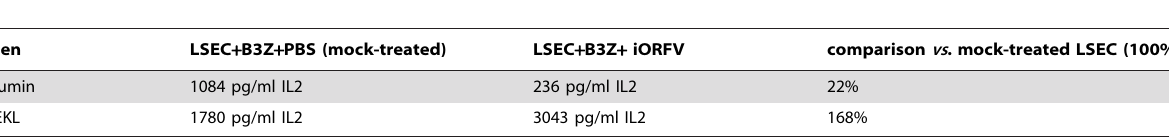
Table 2. iORFV (D1701) reduces antigen cross-presentation by liver sinus endothelial cells (LSEC) but enhances activation of T- cells.